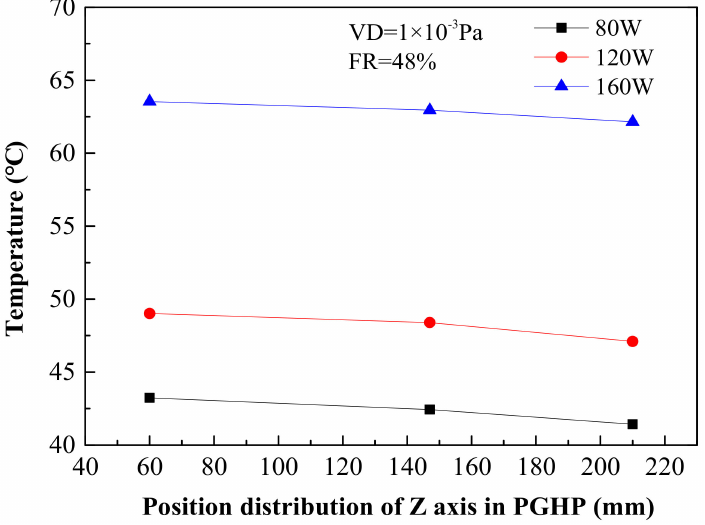
Figure 10. Temperature distribution on the Z-axis of the PGHP at different heating power